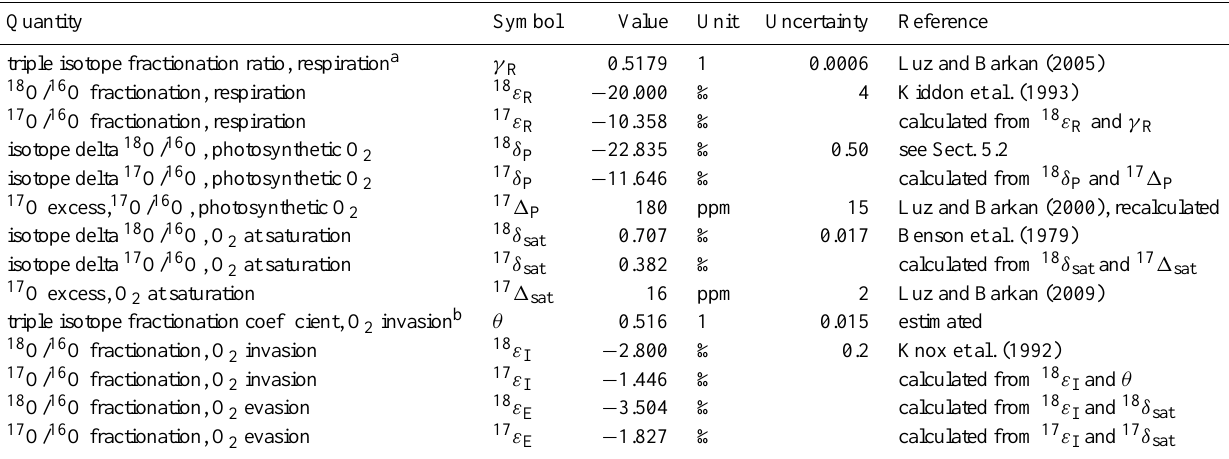
Table 2. Input parameters used as base case in the calculation of g (Sect. 6.1) and their uncertainties (Sect. 5). All δ values are relative to Air-O 2 . The 17 1 values are defined as 17 1 = 17 δ – 0.5179 18 δ (cf. Eq. 8) and expressed relative to Air-O 2 . However, they are not needed for the calculation according to Eq. (48) and are listed for reference only. All values have been adjusted to the same decimal for clarity, irrespective of their actual